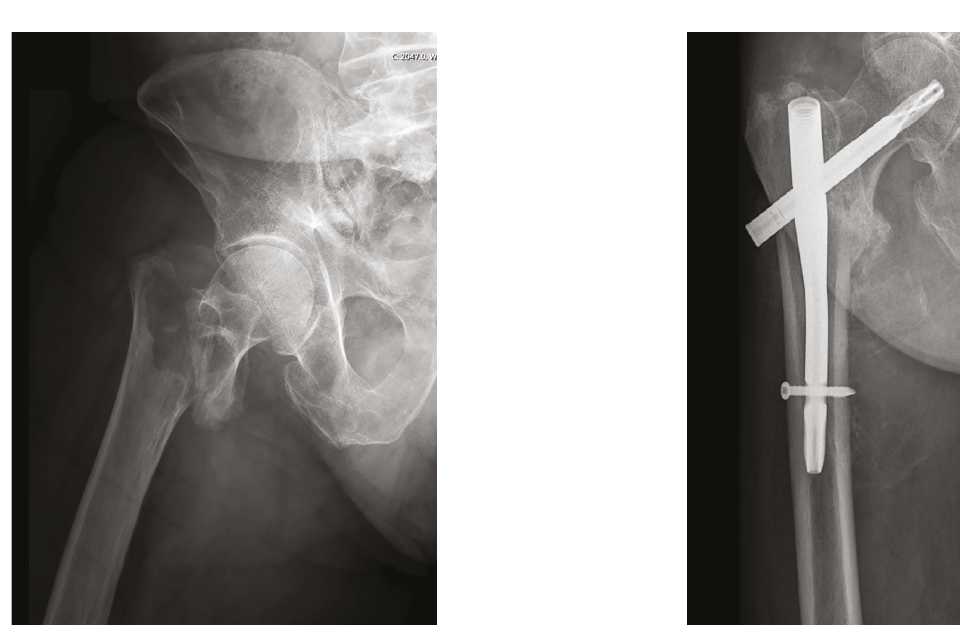
Figure 1: Plain X-ray of the painful hip and pelvis diagnosed a comminuted intertrochanteric hip fracture (grade 31 A2 according to the AO classi fi cation).